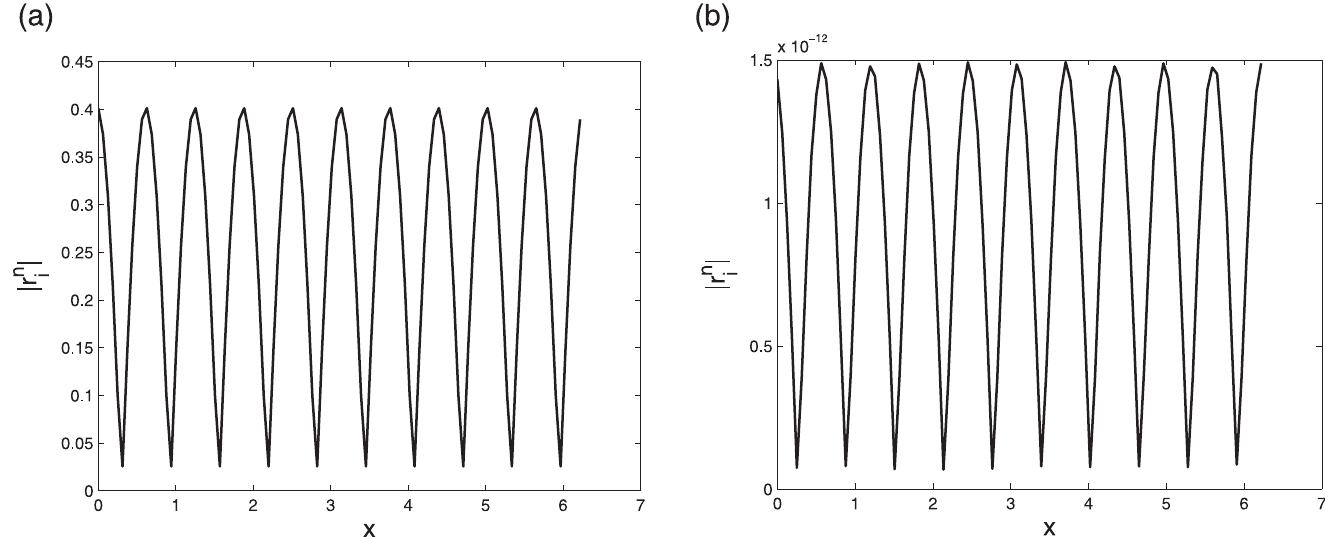
PLOS ONE | https://doi.org/10.1371/journal.pone.0256108 August 27,